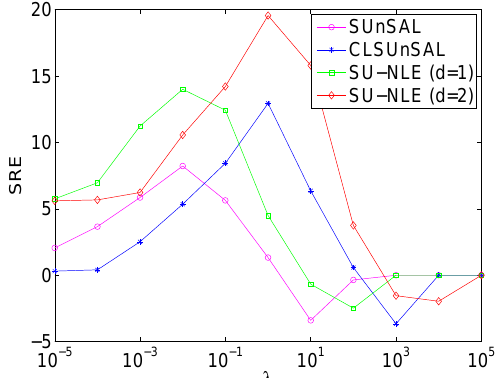
Figure 14. SREs of the methods SU-NLE, SUnSAL and CLSUnSAL as a function of varying regularization parameter λ under correlated noise with both pure and mixed regions having 75 × 75 pixels and 224